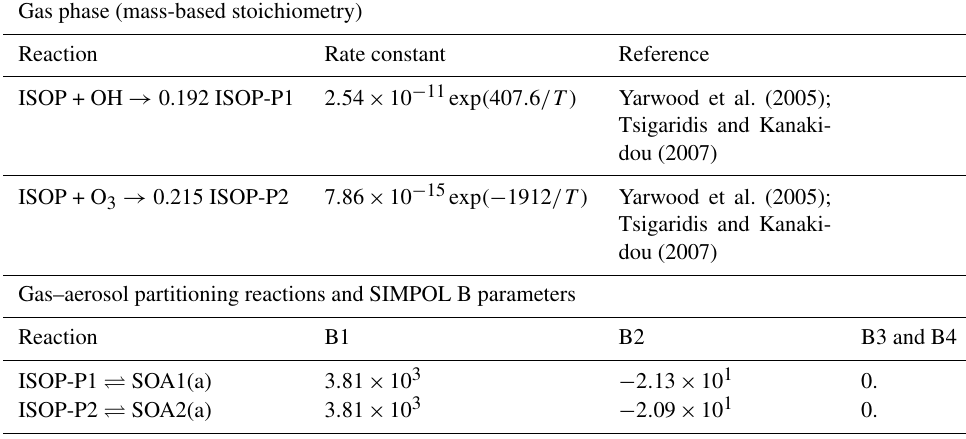
Table 9. Gas–aerosol partition mechanism. Phase transfer reactions are based on the SIMPOL.1 model calculations of vapor pressure de- scribed by Pankow and Asher